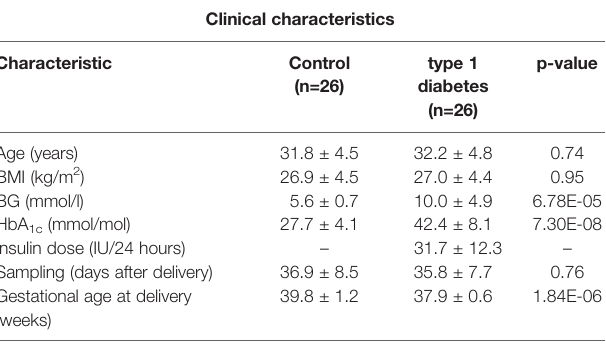
TABLE 1 | Clinical characteristics with mean ± SD and calculated p-values between the 52 participants; lactating mothers with type 1 diabetes (n=26); lactating healthy mothers